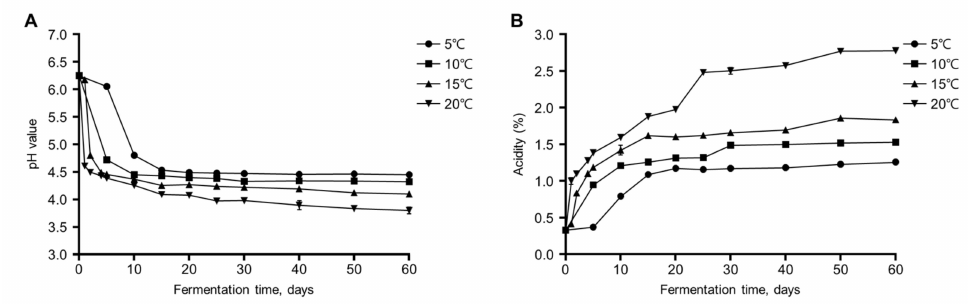
Figure 1. Changes in the pH and acidity of gajami-sikhae samples during the fermentation at different fermentation temperatures: ( A ) pH profiles; ( B ) acidity profiles. Error bars represent the mean ± standard